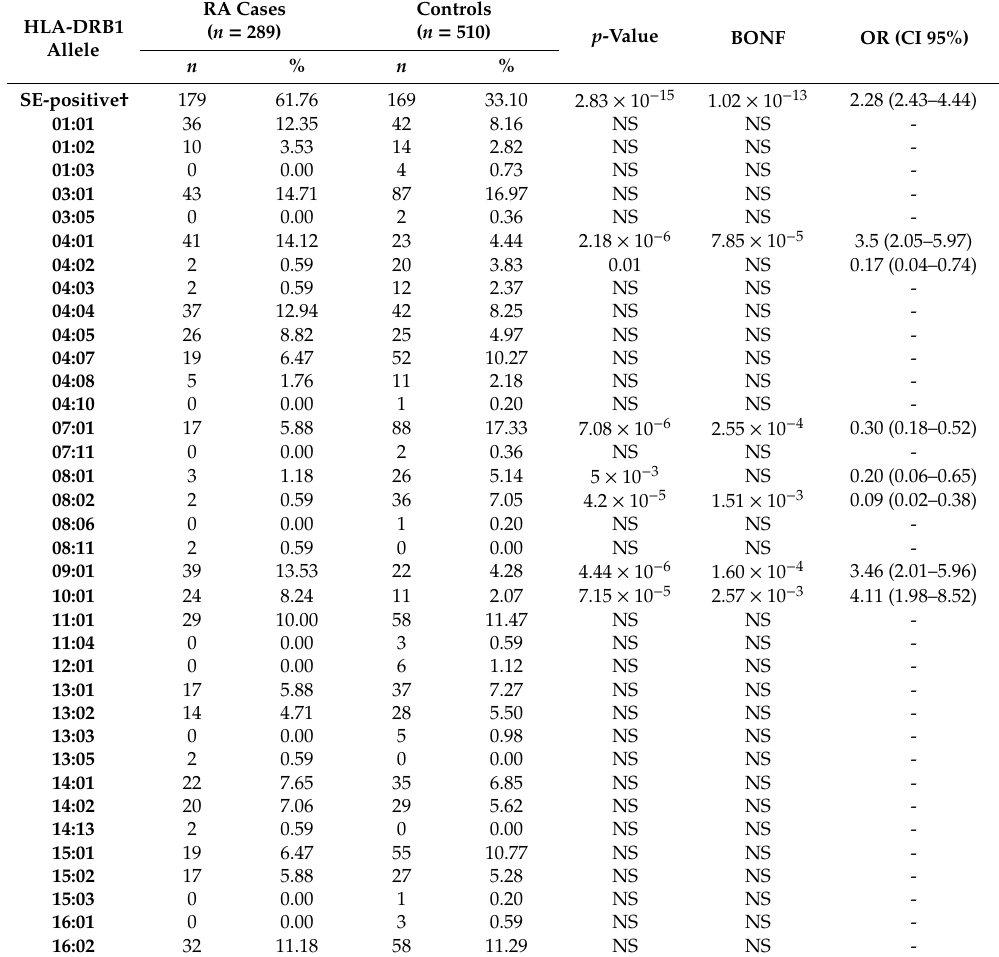
Table 3. Distribution of HLA–DRB1 alleles in patients with rheumatoid arthritis and healthy controls. HLA-DRB1